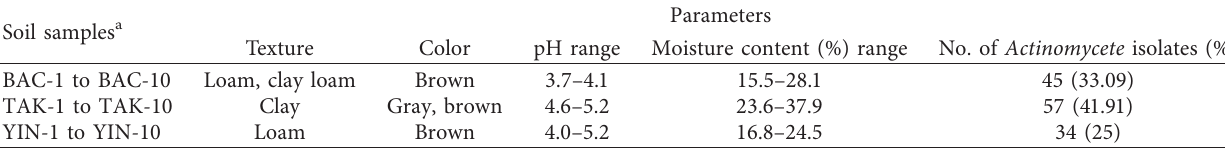
Table 1: Physicochemical characteristics and abundance of Actinomycete isolates found in soil samples at diverse sampling areas.